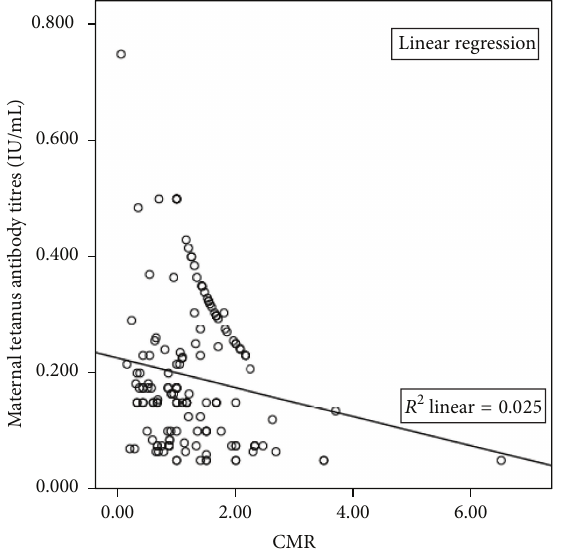
Figure 2: Pearson correlation between maternal anti-tetanus anti- body titres and cord-maternal ratios